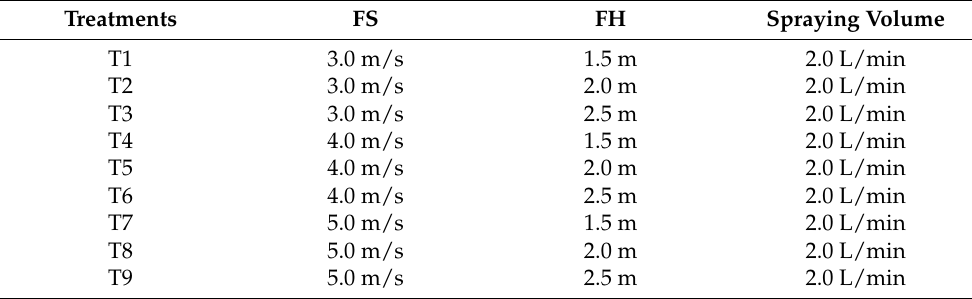
Table 3. The experiment treatment